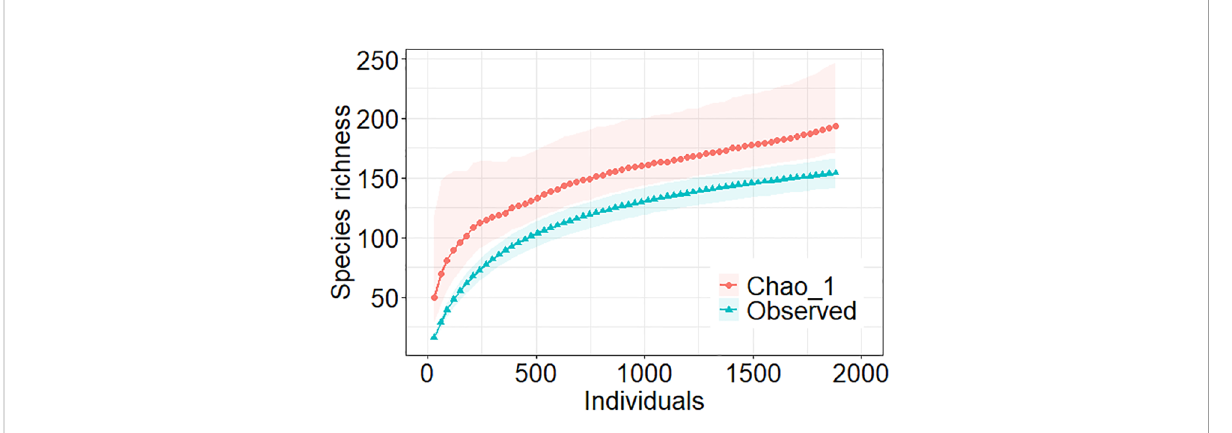
FIGURE 6 Accumulation curves of nematode species richness versus individuals of 63 sites in the Southwestern Gulf of Mexico. Two metrics of richness were given: Observed and non-parametric estimator Chao 1. Shaded areas indicated 0.95 con fi dence intervals generated by